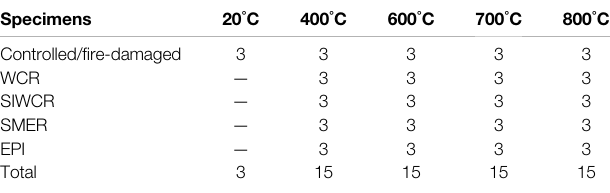
TABLE 6 | Number of concrete cylinders cast for testing.